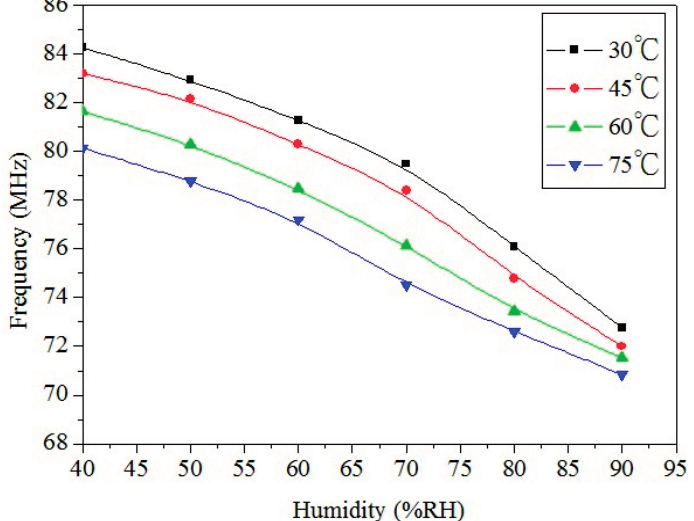
Figure 12. Measured output frequency of the humidity sensor at different